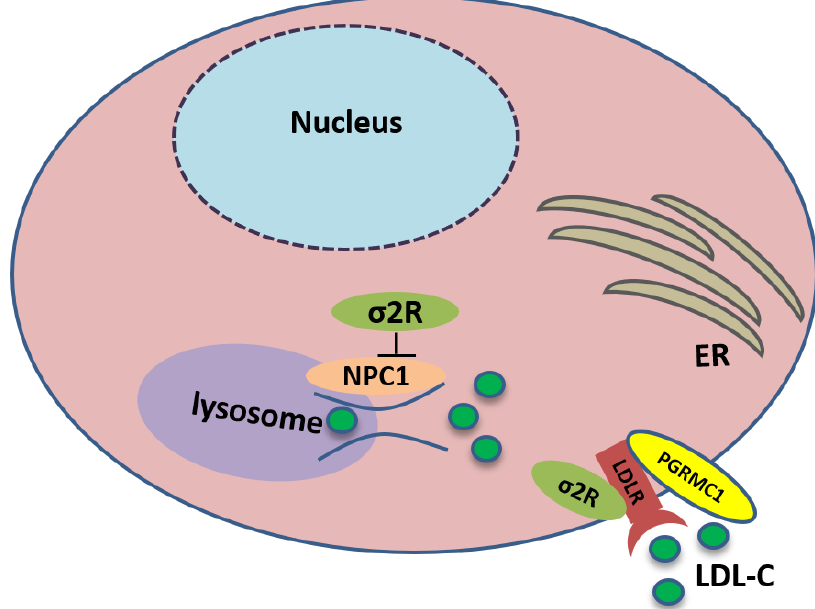
Figure 3. Sigma-2 receptor controls the trafficking of cholesterol. TMEM97 forms a trimeric complex with progesterone receptor membrane component 1 (PGRMC1) and low-density lipoprotein receptor (LDLR), which is responsible for the internalization of LDL. In addition, TMEM97 is a Niemann-Pick C1 (NPC1) binding protein and controls the trafficking of cholesterol out of lysosomes.